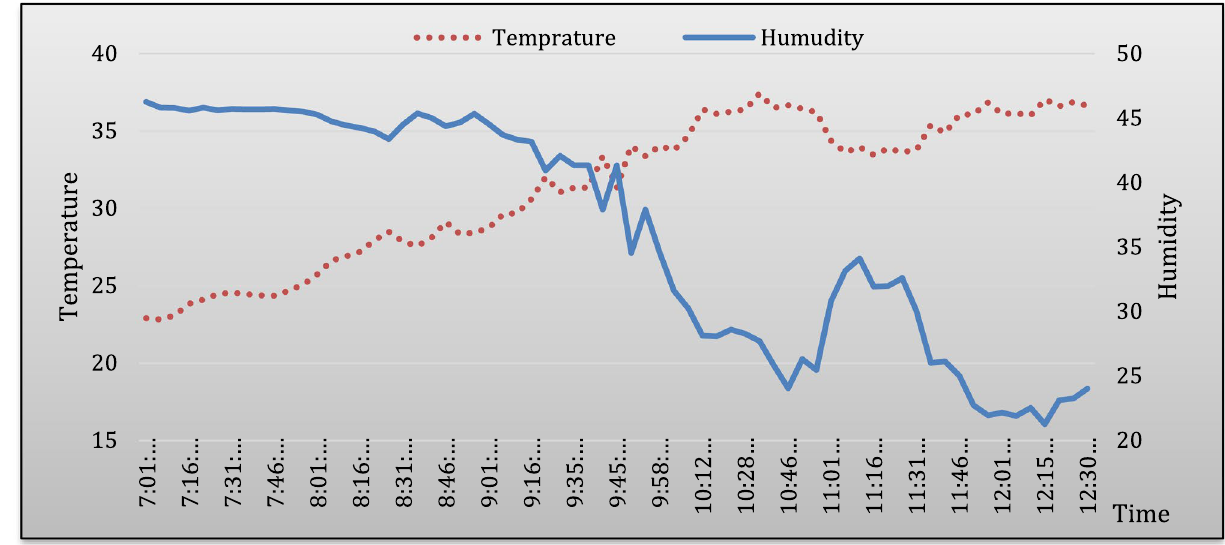
Fig. 5 Results of the experiment carried out on